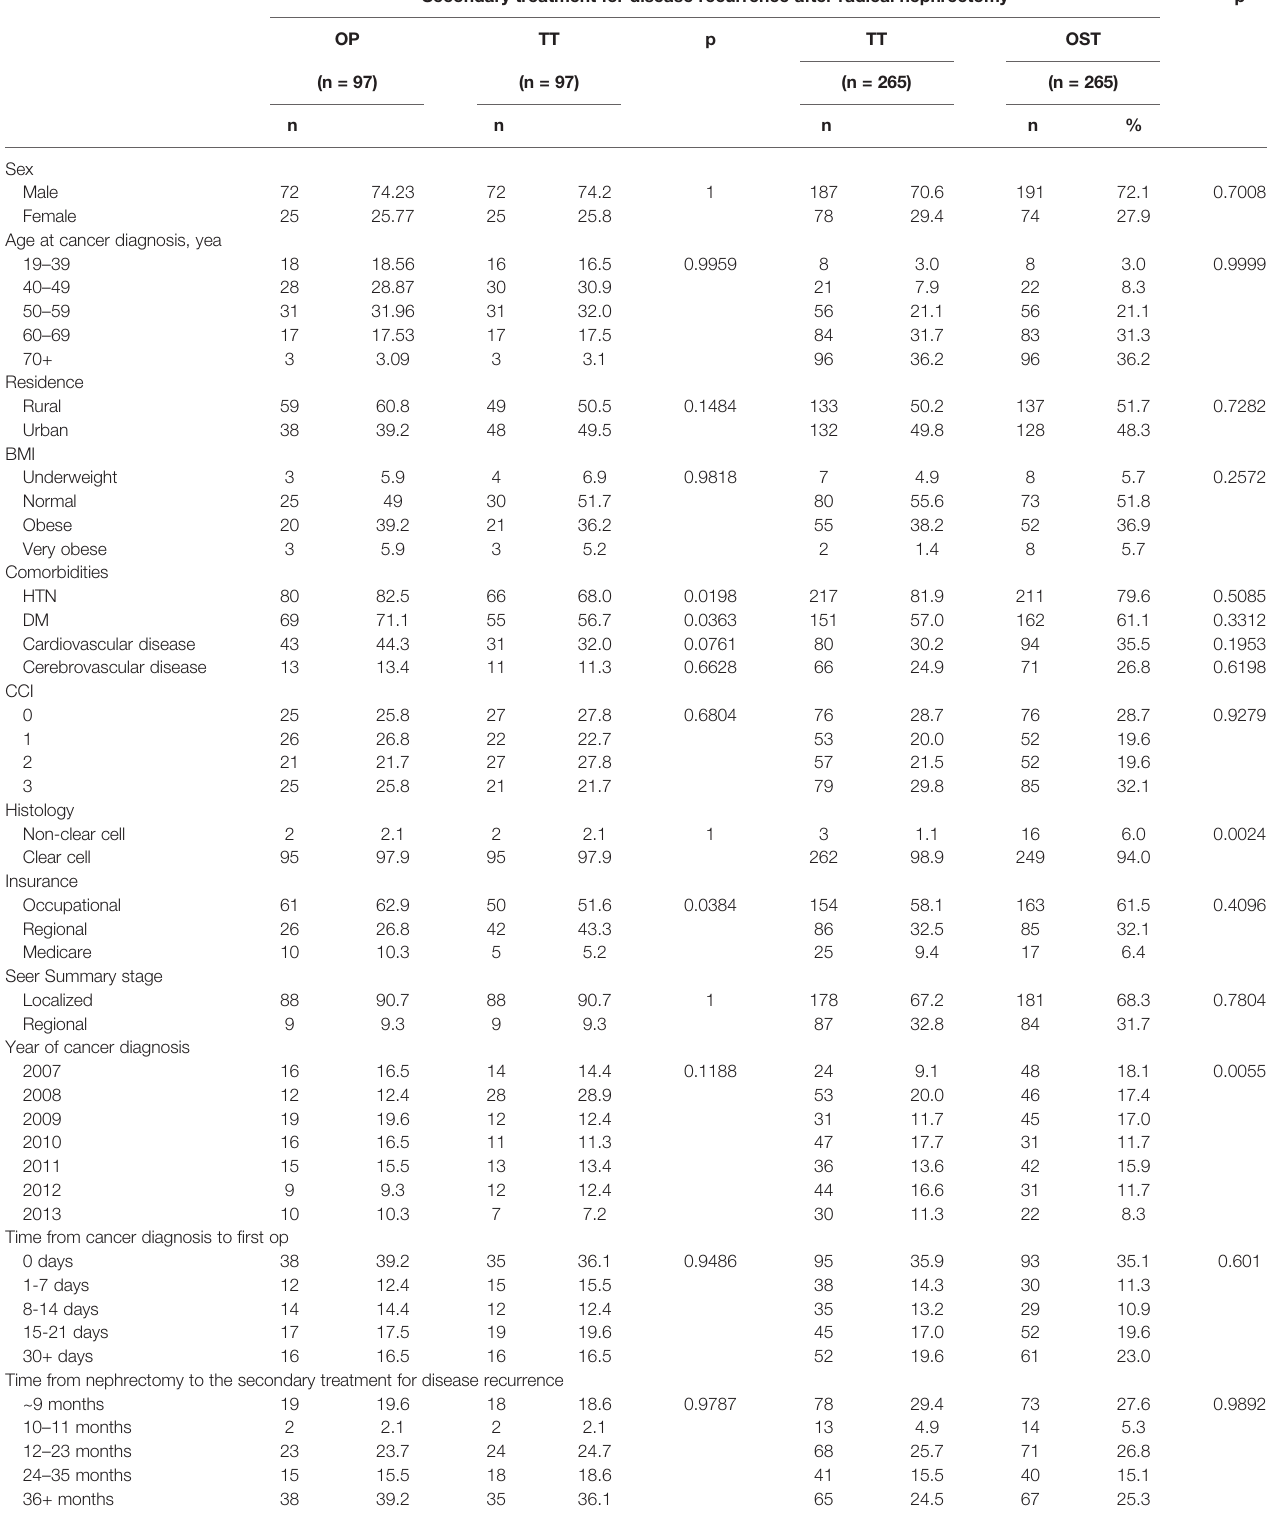
TABLE 5 | PS matching 1:1 adjusted by matching variable: gender, SEER staging, CCI, and age.